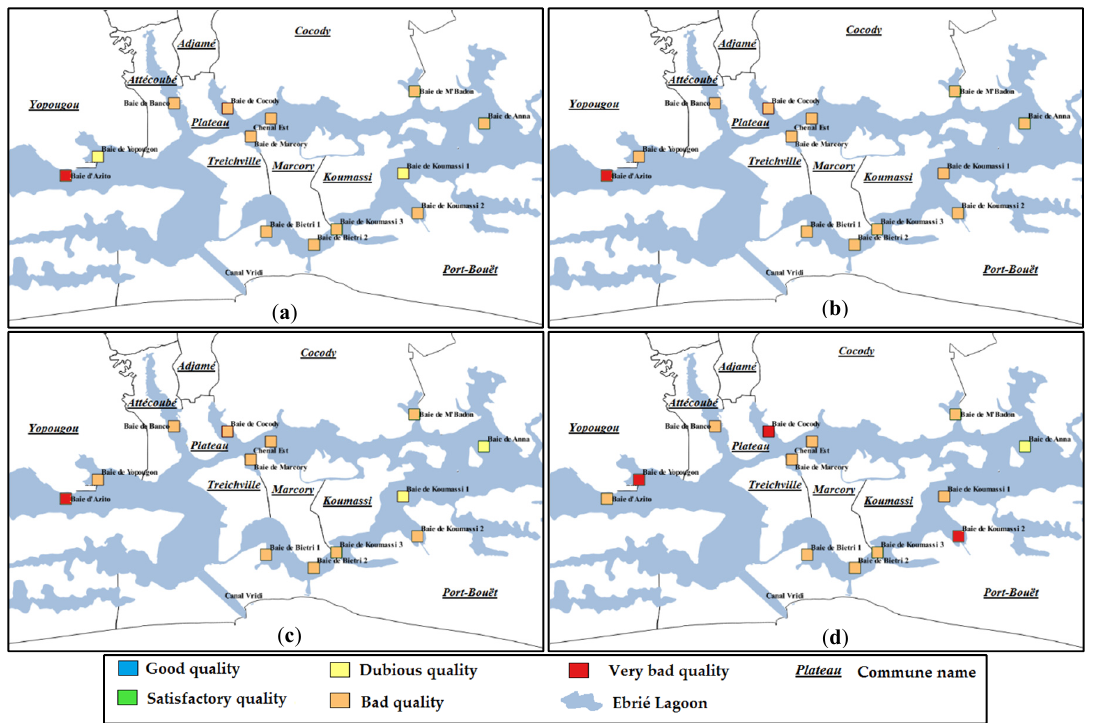
Figure 5. Spatio-temporal variation of the Water Quality Index for irrigation: ( a ) June 2014; ( b ) June 2015; ( c ) December 2014; and ( d ) December 2015.